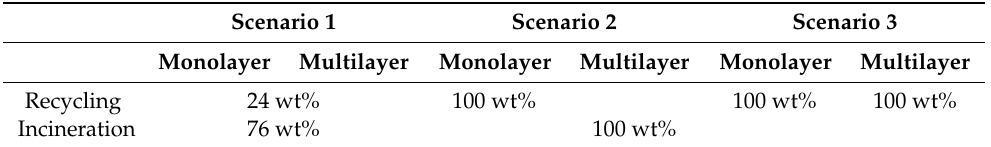
Table 5. Different scenarios for the assessment of the contribution of multilayer films to the Austrian plastic packaging